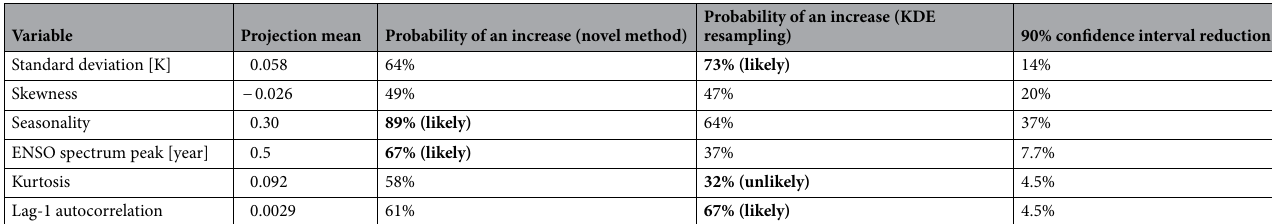
Table 3. Summary of ENSO multi-model projections. Key properties of multi-model probabilistic ENSO projections for changes between years 1850–1949 and 2040–2099 from CMIP6 climate models under the SSP585 forcing scenario using the novel method and compared to the poor man’s approach of resampling of PDFs obtained using kernel density estimation. Probability of increase is re-stated using the IPCC uncertainty guidance note terminology 45 . Likely changes (using the IPCC guidance note terminology) are shown in